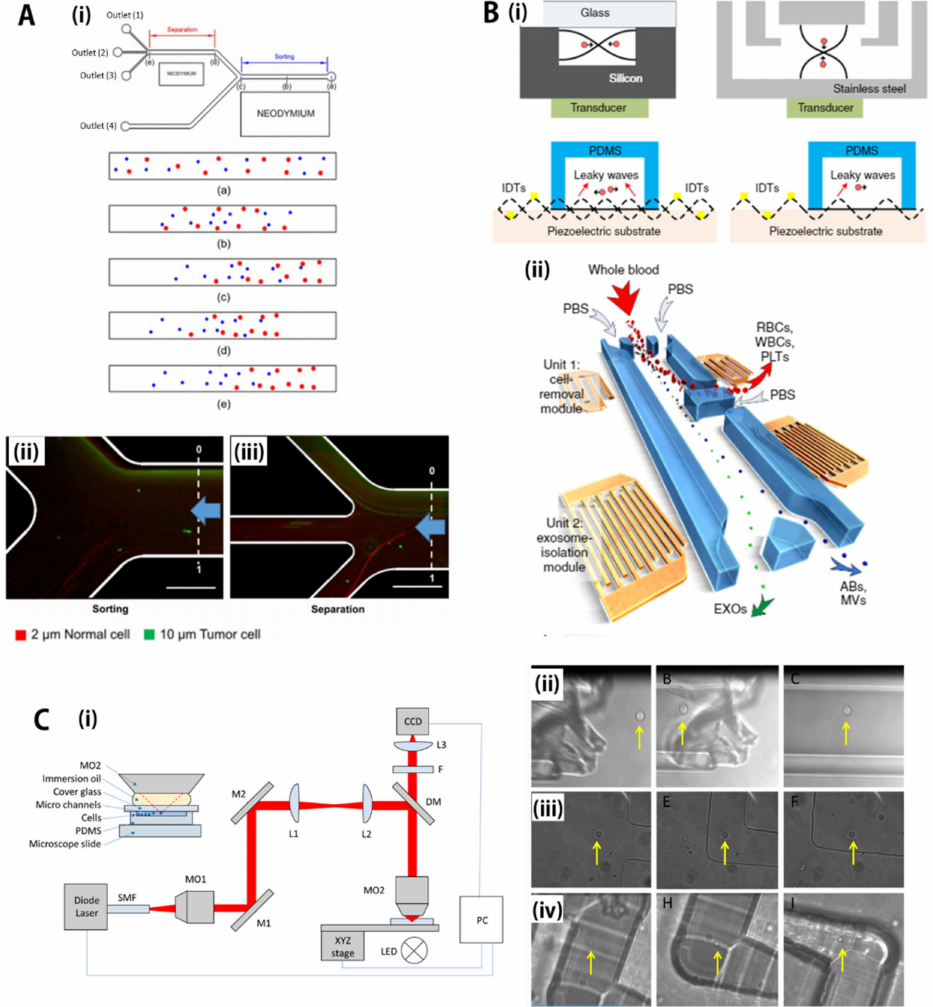
Figure 4. Microfluidic active-force separation group 1: non-contacting, external force-based separa- tion. ( A ) ( i ) Illustration to show sorting and separation using magnetic field (neodymium) acting